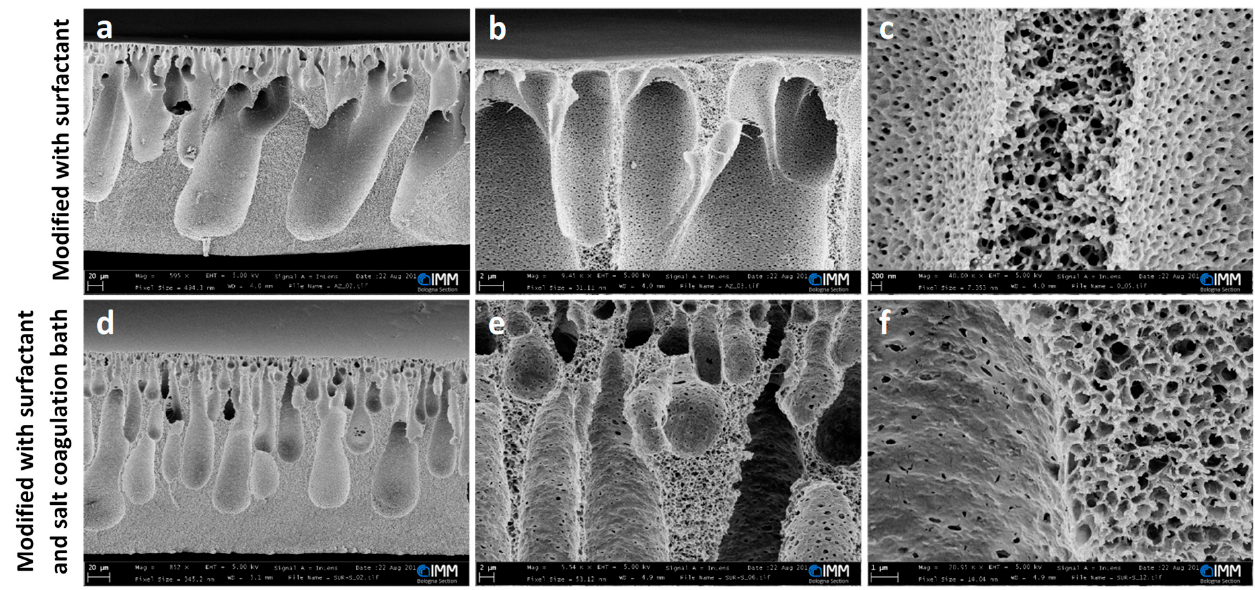
Figure 3. SEM images at different magnifications of membranes modified with P127 surfactant ( a – c ) and membranes modified with P127 surfactant and salt coagulation bath ( d – f ). The film applicator speed was 5 mm/s and the thickness of the casted solution was 500 µm. The scale bars are, from the lowest to the highest magnification: ( a , d ) 20 µm, ( b , e ) 2 µm, ( f ) 1 µm, and ( c ) 200 nm.